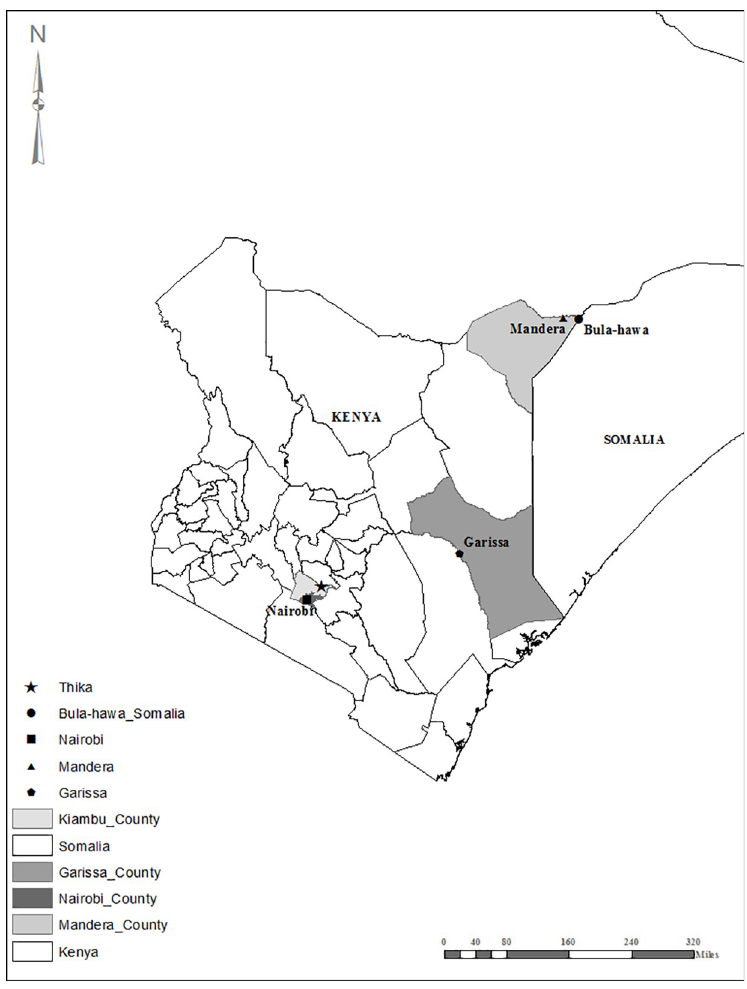
Fig 1. Map of Kenya showing regions from which human samples were obtained for